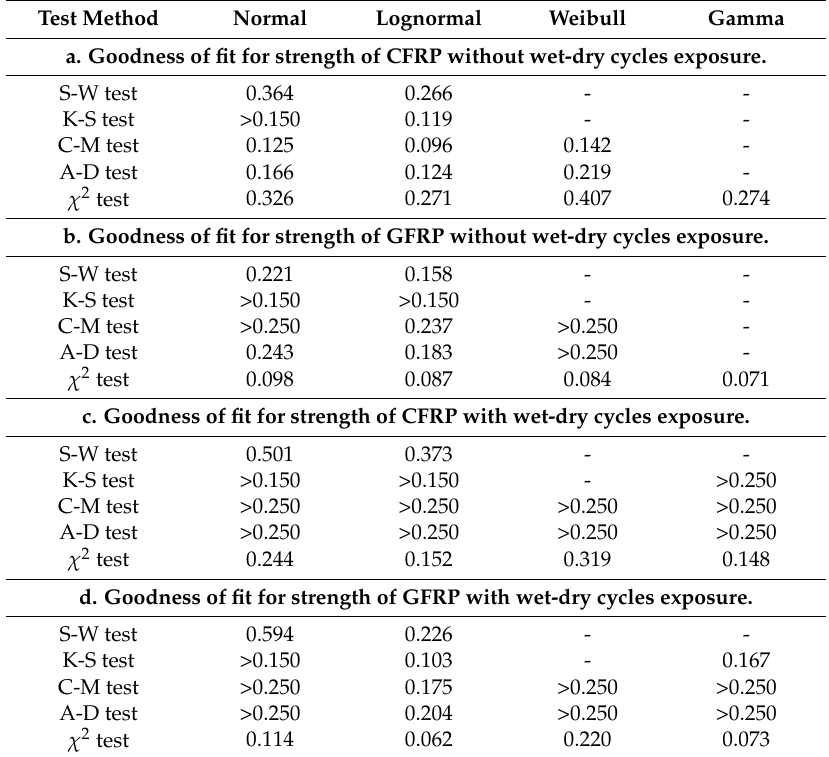
Table 3. Test results of probability distribution of tensile strength of